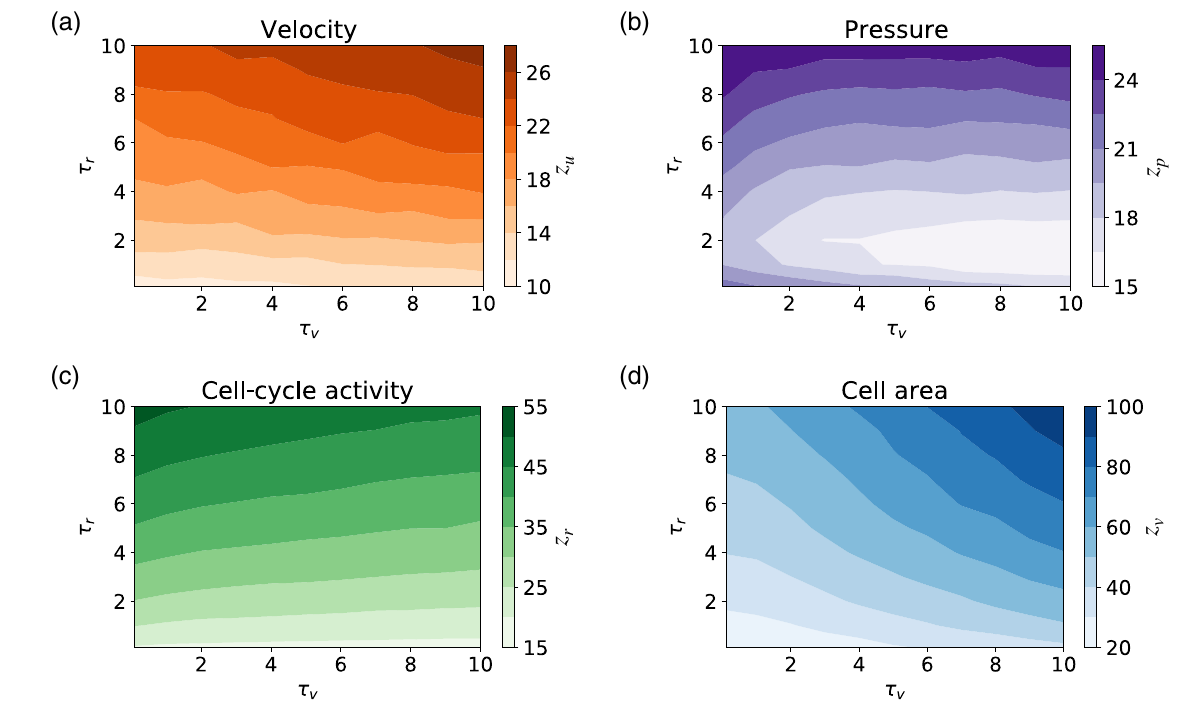
FIG. 5. The dimensionless half-decay lengths for velocity u , pressure p , cell-cycle activity r , and cell area (2D volume) v near the growth front depend differently on the two dimensionless cell-cycle times τ